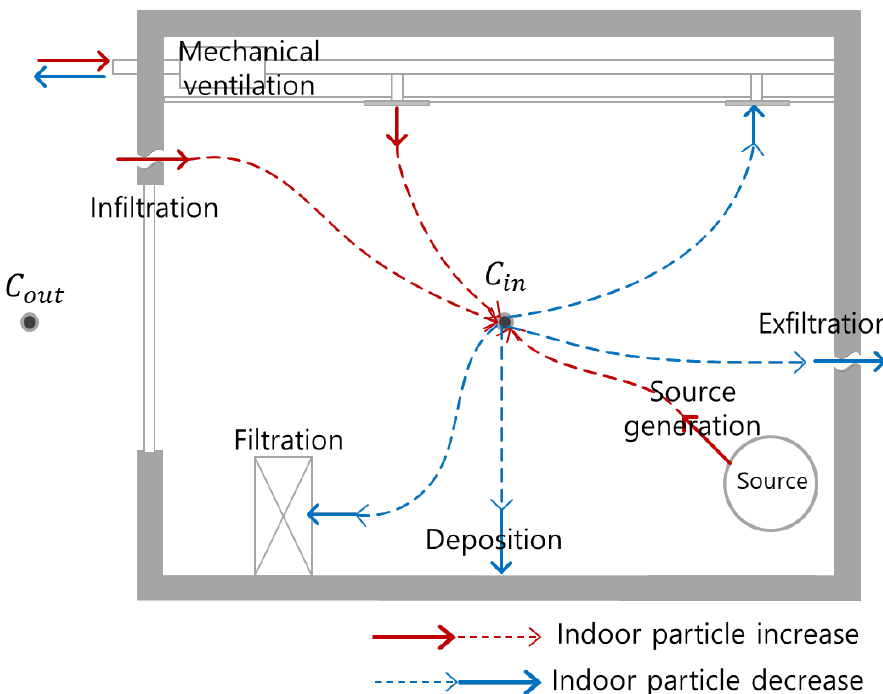
Figure 2. PM2.5 concentration mechanism in a space with a mechanical ventilation system and portable filtration system.